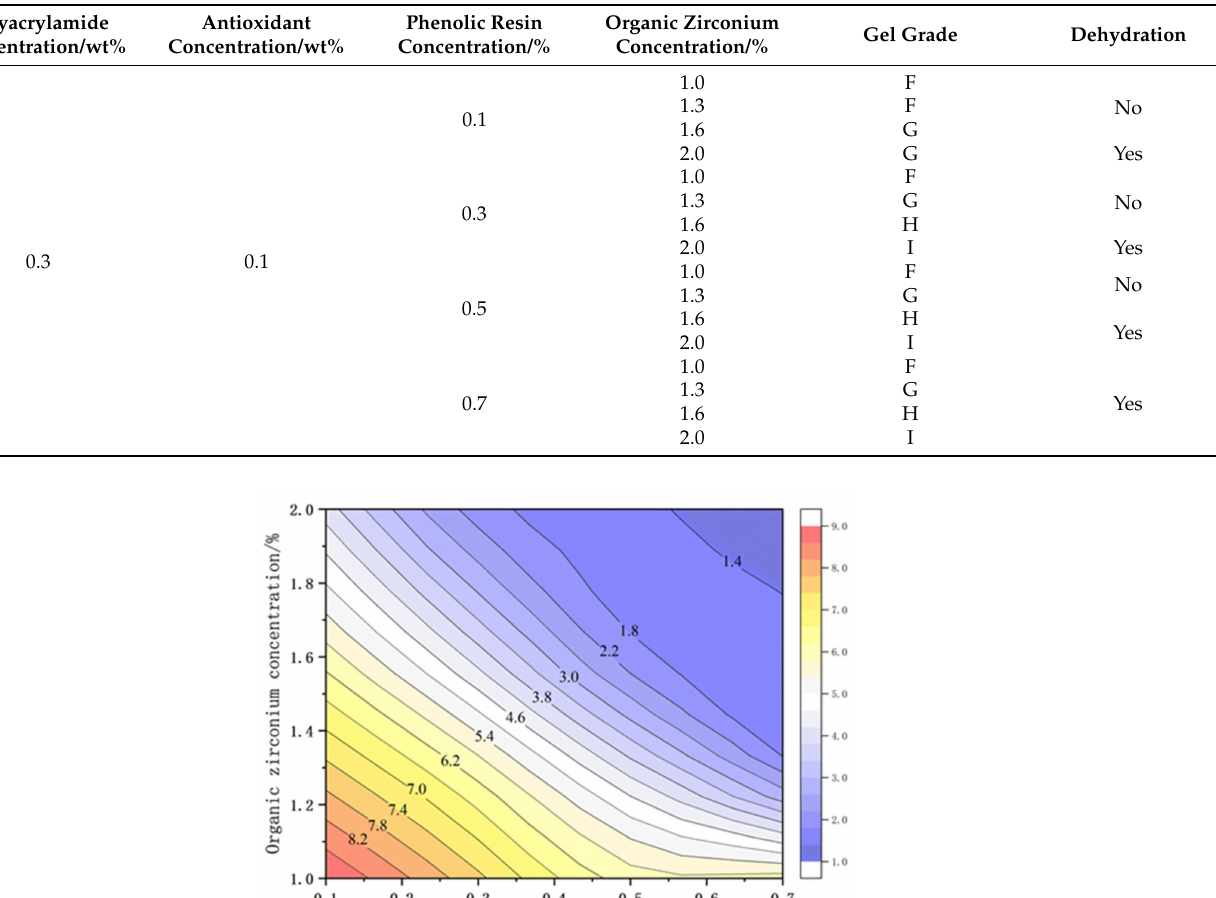
Table 3. The experimental settings and results of the secondary cross-linking reactions.